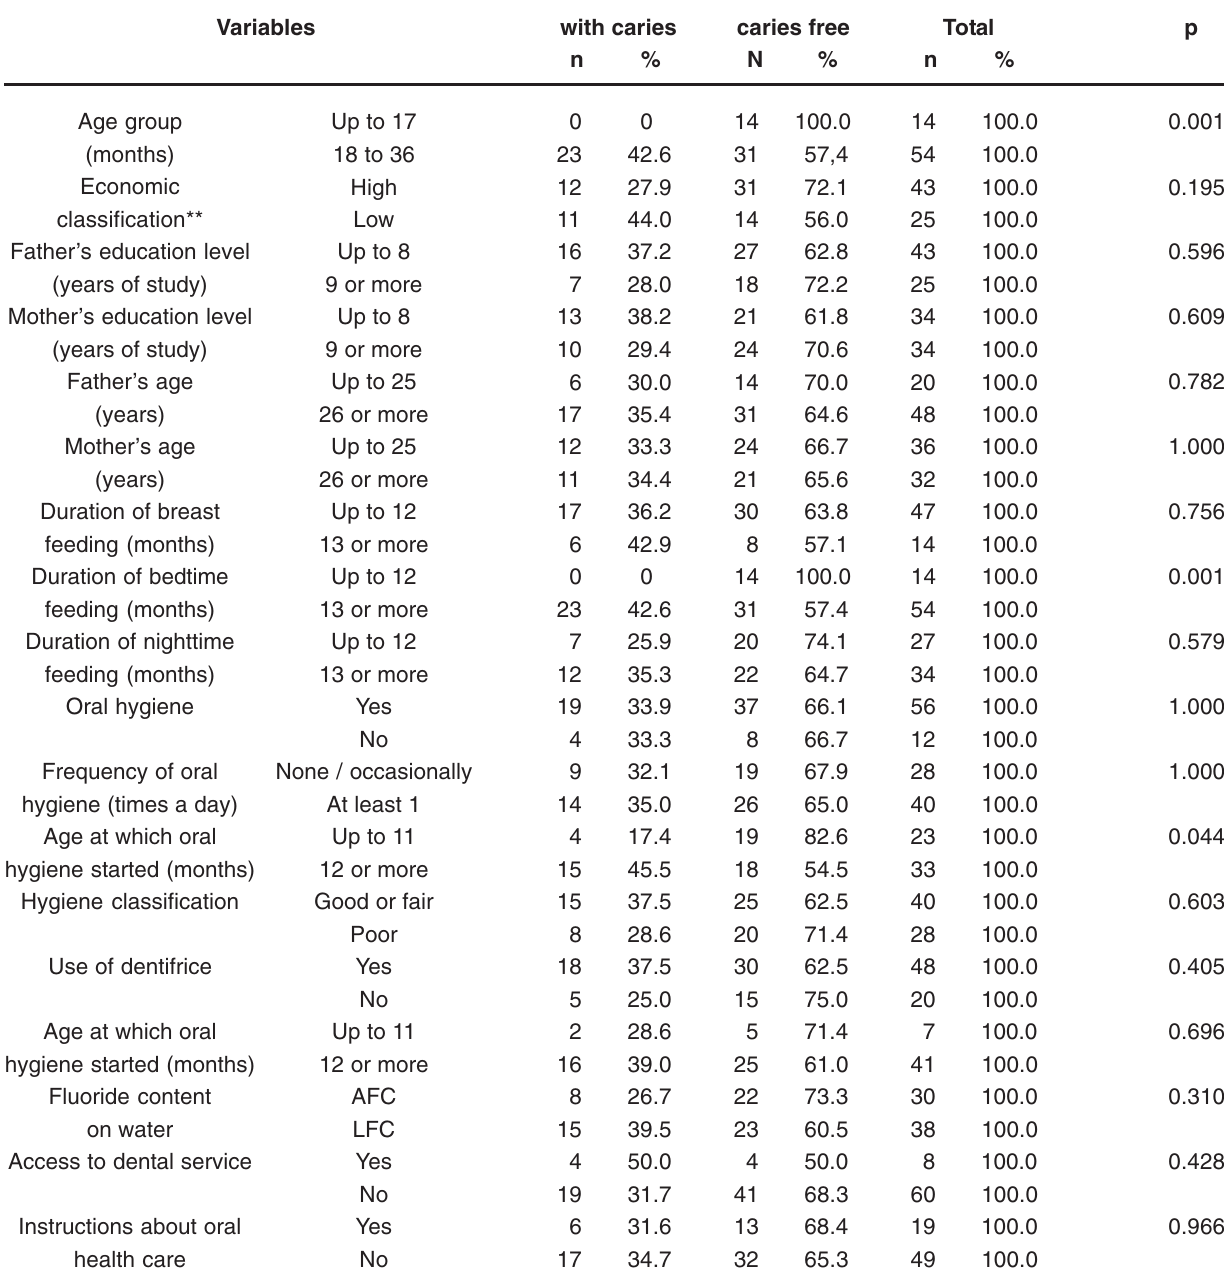
TABLE 3- ECC prevalence regarding the studied